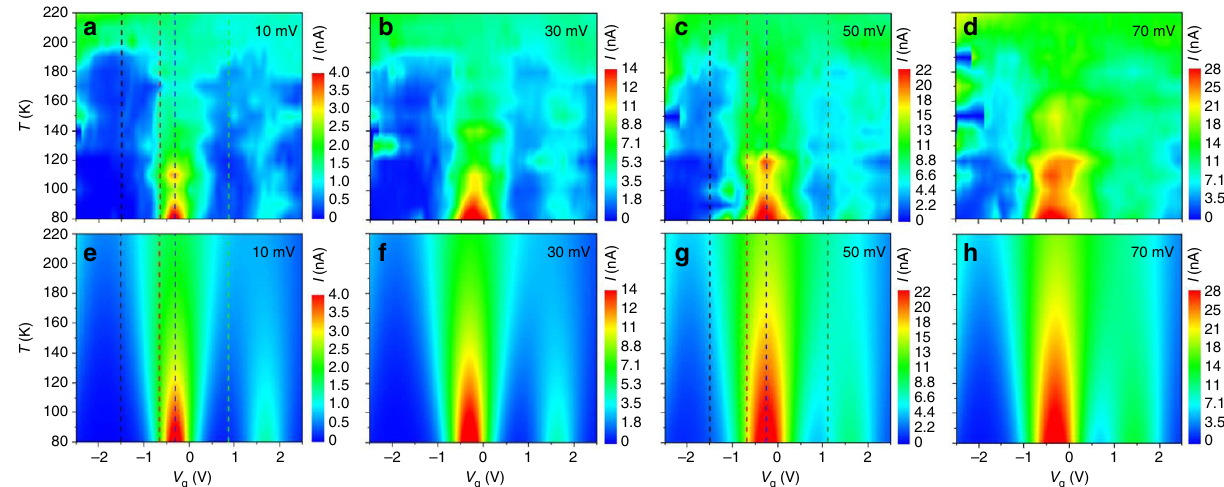
Figure 4 | Variable temperature and source-drain voltage charge transport. Contour colour-code plots of the current as a function of the gate voltage and temperature for both experimental data ( a – d ) and calculations ( e – h ) using the single-level tunnelling transport model in equation (1) for V sd ¼ 10, 30, 50 and 70mV. The vertical dashed lines in a , c , e and d indicate data and calculations presented in Fig. 5.